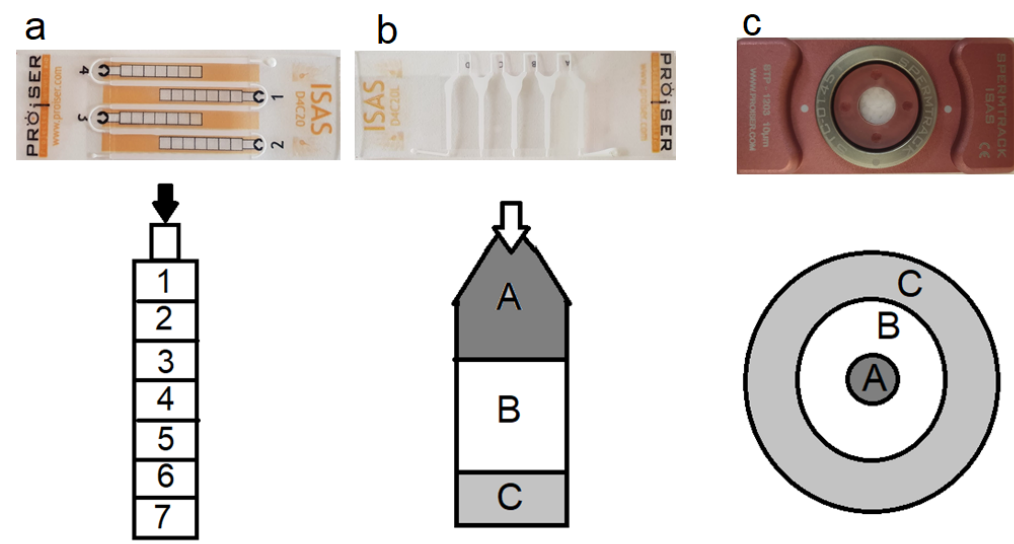
Figure 1. The di ff erent chambers types and forms used and the filed analyzed. ( a ): Disposable chamber D4C10, D4C20. ( b ): Disposable chamber D4C20L and ( c ): Reusable chambers SpK10, SpK 20.